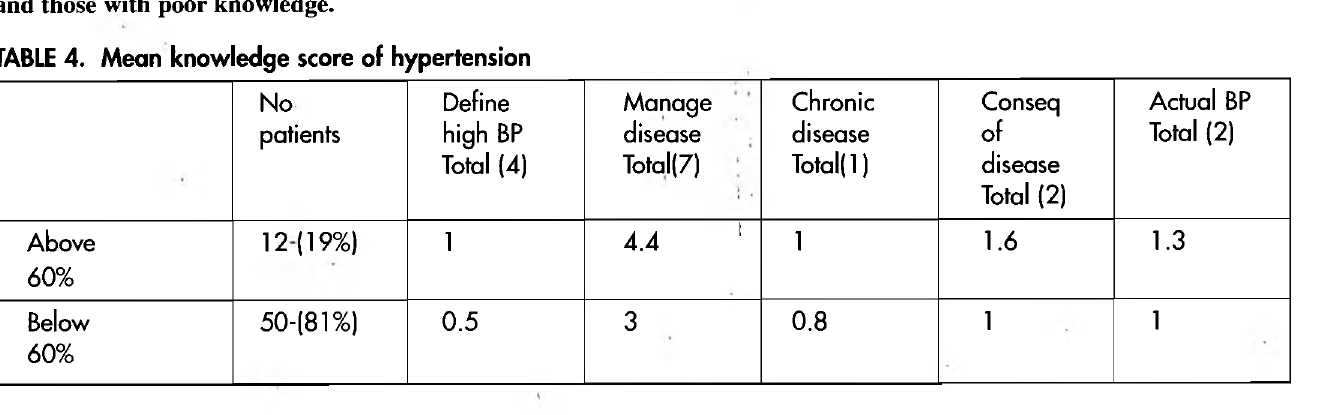
TABLE 4. Mean knowledge score of hypertension